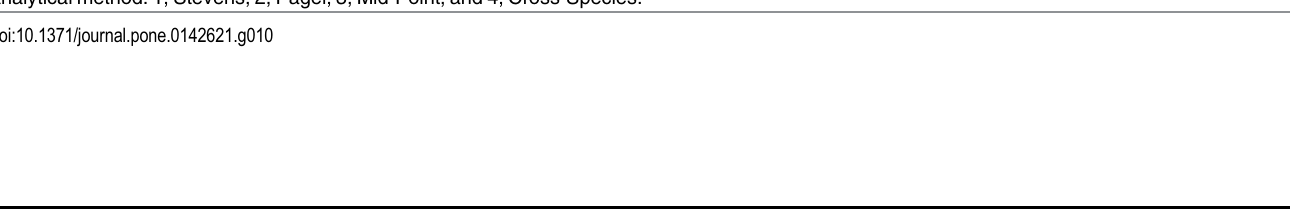
PLOS ONE | DOI:10.1371/journal.pone.0142621 November 10,